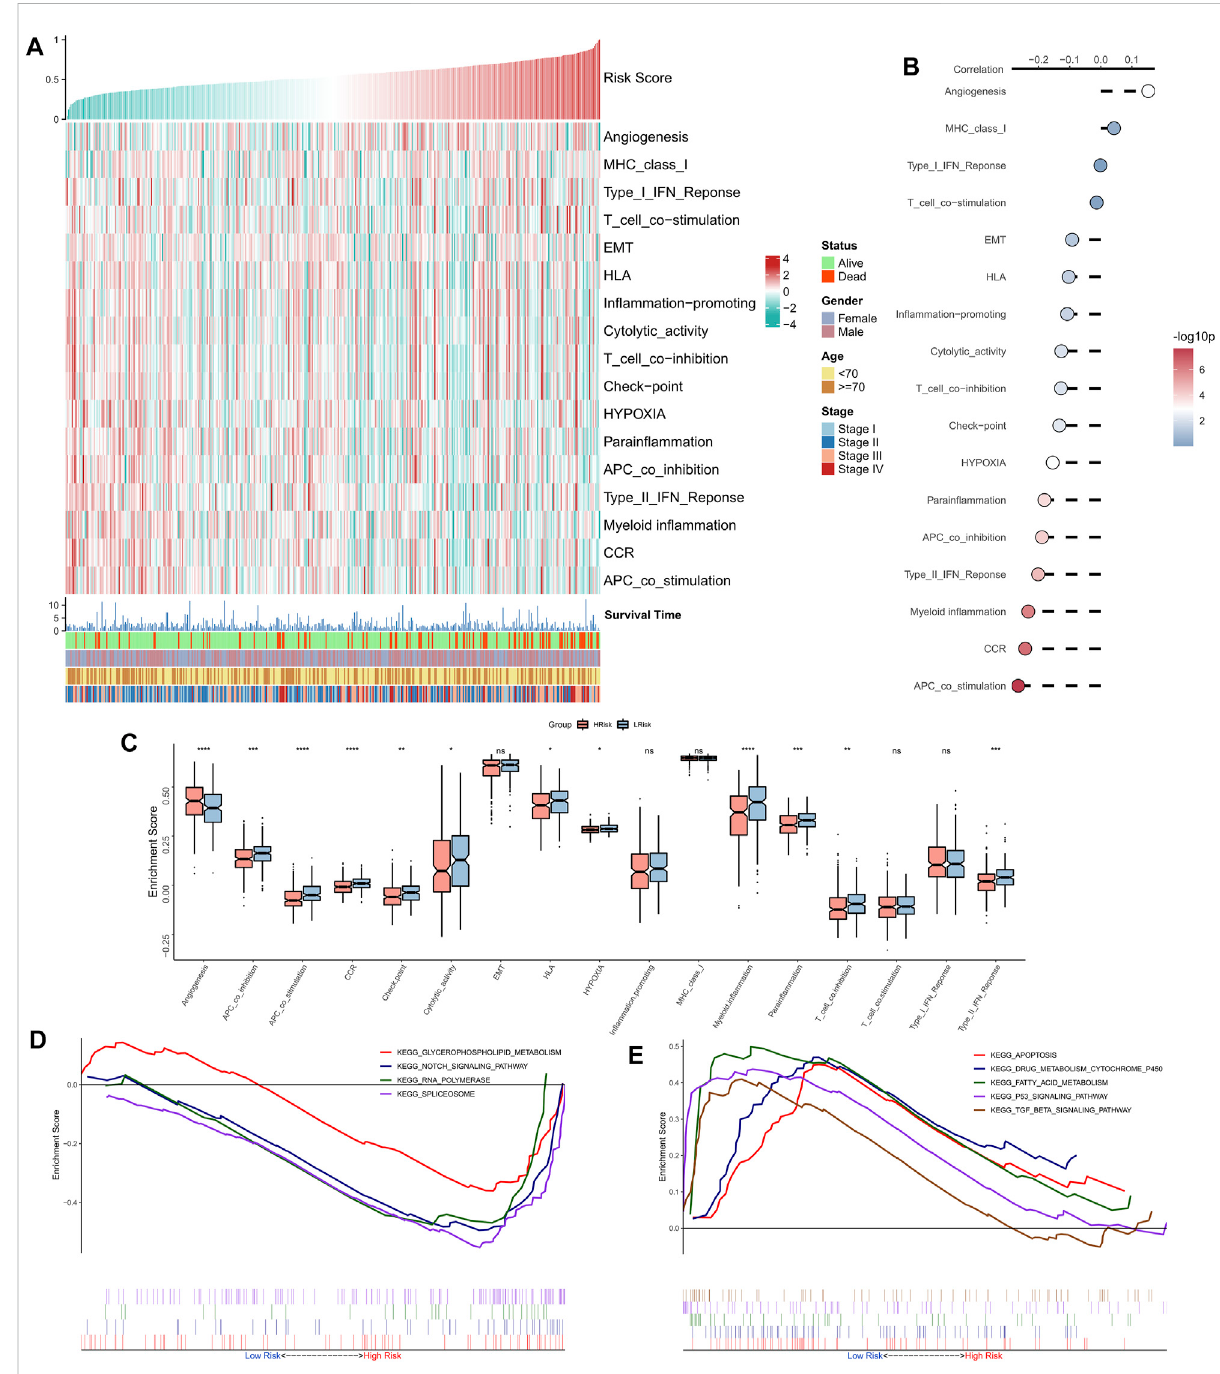
FIGURE 4 Functional analysis of the NRG-related risk model. (A) . Heat map showing the correlation between RiskScore, activities of biological pathways, andclinicalcharacteristics; (B) .CorrelationanalysisbetweenRiskScoreandbiologicalpathways; (C) .Boxplotsshowingthedifferencesinactivitiesof thebiologicalpathways between thehigh-riskandlow-risk groups; (D) .GSEAenrichmentplotshowingthefourpathways ofinterestinthehigh-risk group; (E) . GSEA enrichment plot showing the 5 pathways of interest in the low-risk